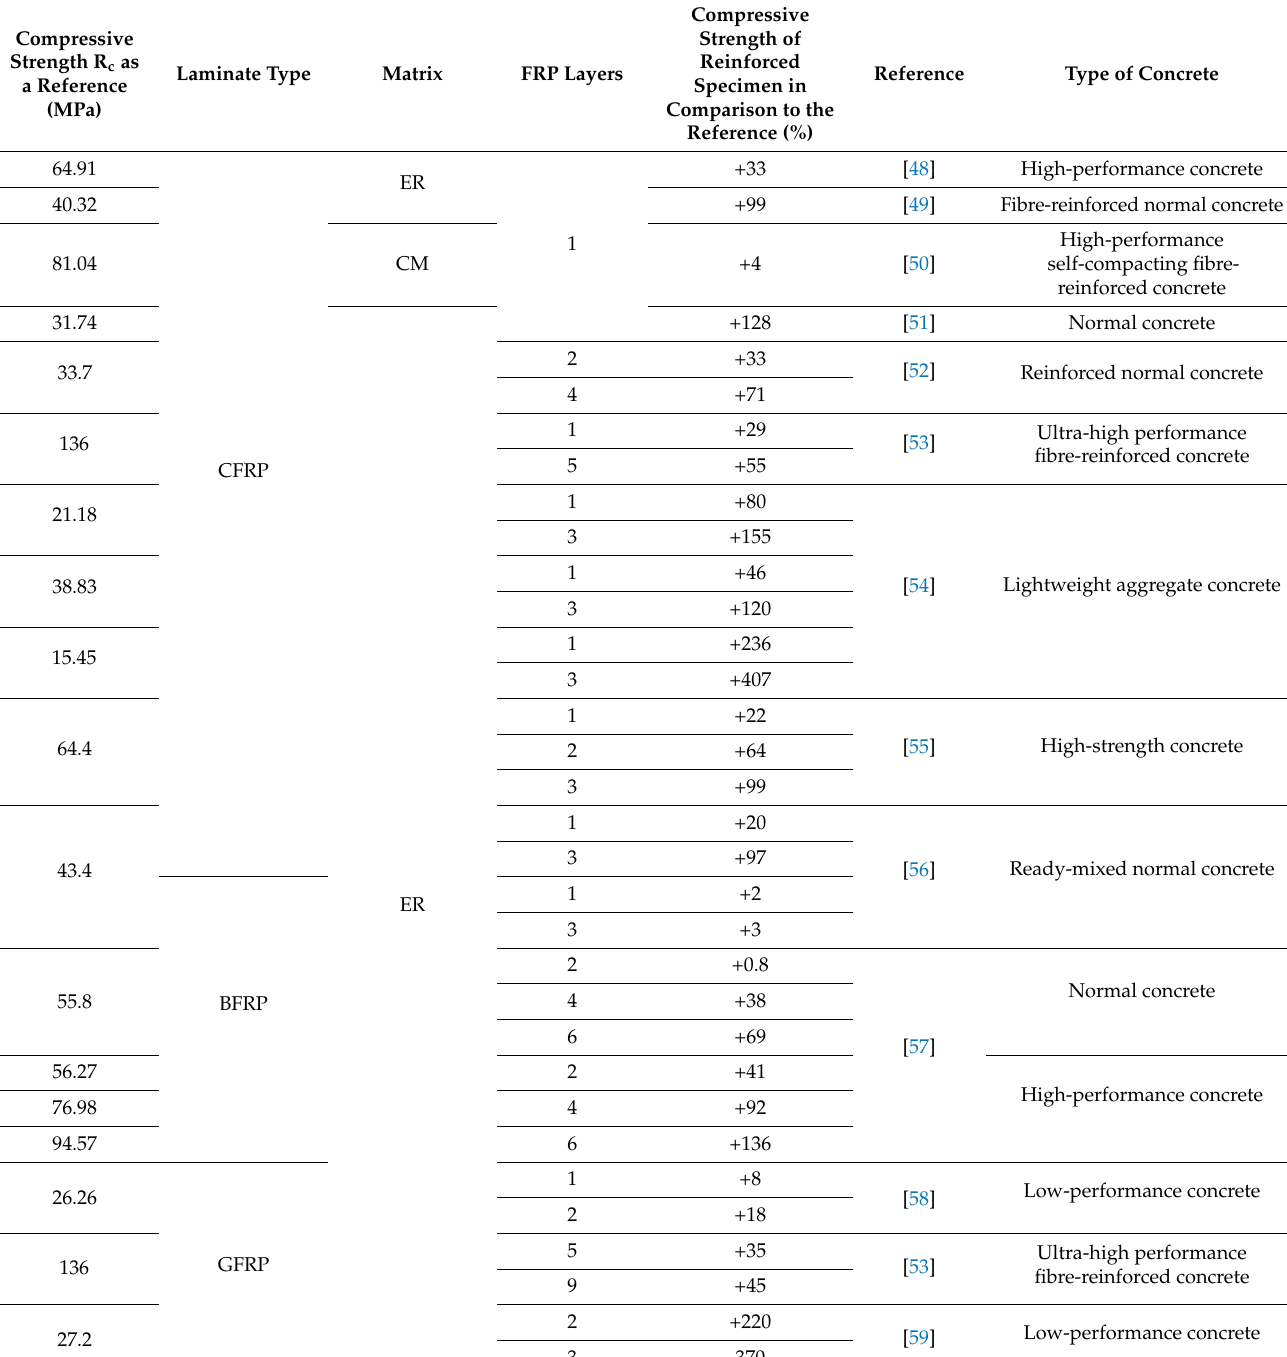
Table 5. Influence of FRP composites on the behaviour of